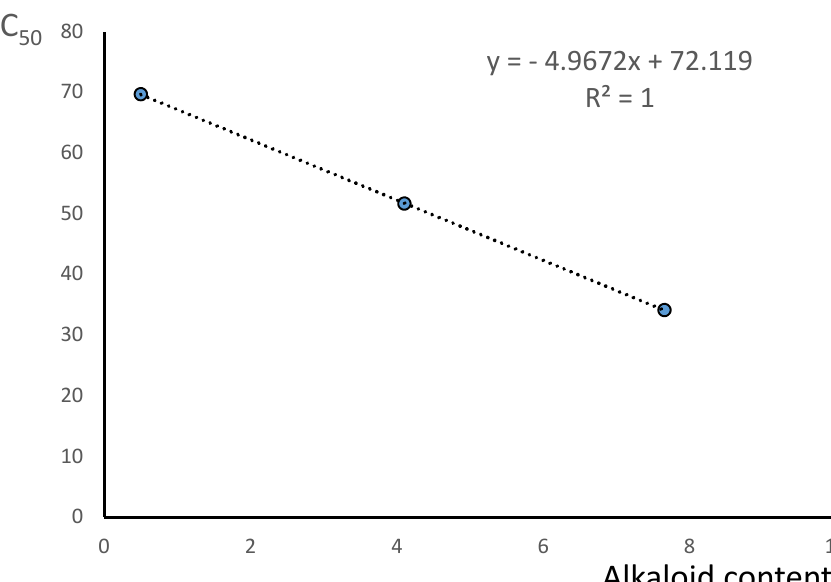
Figure 11. Correlation between contents of berberine and palmatine in M. aquifolium extracts obtained from various parts of plant collected during flowering with cytotoxic activity against A375 cell line. Table 4. Equation of correlation curve and correlation coefficients (r), values between isoquinoline alkaloid contents and cytotoxic activity expressed as IC 50 of investigated plant extracts.